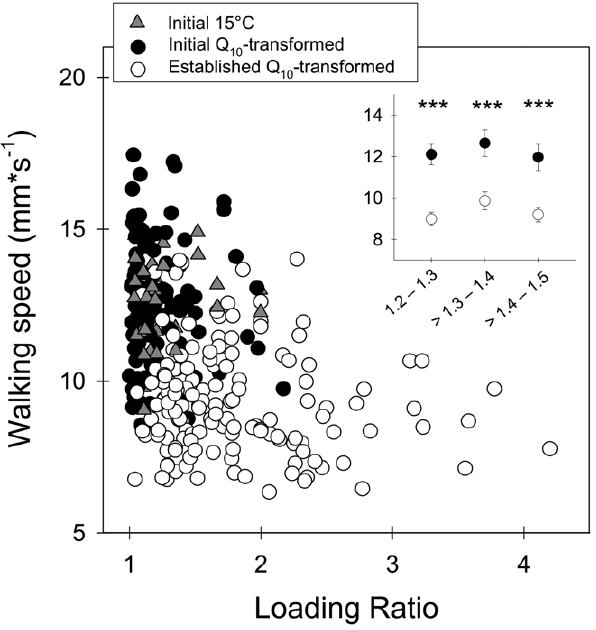
Figure 5. Walking speed of laden workers as a function of the Loading Ratio (LR=[Load mass + Ant mass]/Ant mass), for both the initial and established foraging phases. Speeds measured at temperatures other than 15 u C, during both foraging phases, were transformed to comparable values at 15 u C using the Q 10 -values obtained from the speed measurements in the laboratory, as shown in Figure 4 (further details in text). Walking speed of workers walking at 15 u C ( 6 0.1 u C) during the initial foraging phase remained untrans- formed (gray triangles). Inset : Detailed view of the mean walking speeds for different ranges of loading ratios: 1.2–1.3; . 1.3–1.4; . 1.4– 1.5. Asterisks denote statistical differences between the initial and established phase at p , 0.001 (for the loading ratios values 1.2–1.3: t 32 =5.41; . 1.3–1.4: t 31 =3.70; . 1.4–1.5: t 31 =4.17).